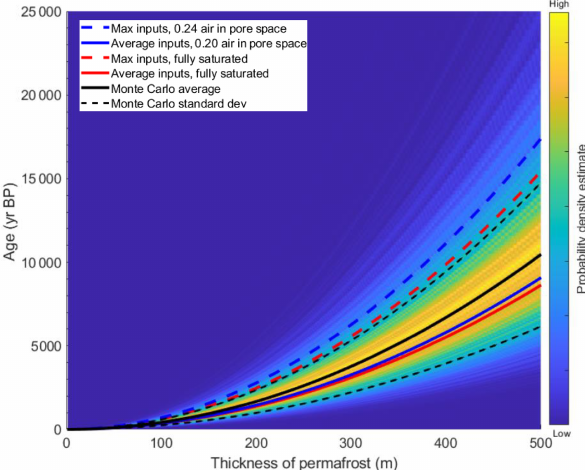
Figure 11. Monte Carlo age versus elevation probability for 10000 iterations of Eq. (1) with average inputs and assigned standard de- viation. Monte Carlo average result shown as solid black line and 1 standard deviation as dashed black line. Permafrost ages for aver- age (solid) and maximum inputs (dashed) into Eq. (1), for partially (blue) and completely saturated (red) conditions. Maximum inputs with air fraction in pore space of 0.24 yields maximum possible ages (dashed blue). Data density is displayed as a color ramp, where yellow points indicate higher data density, and blue points indicate lower data